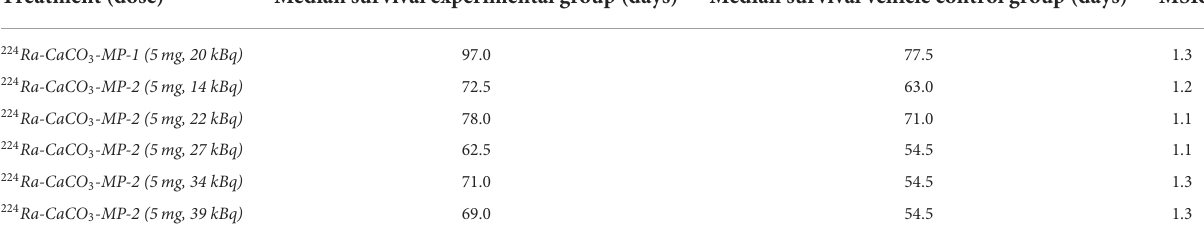
TABLE 1 Median survival ratios (MSRs) for 224 Ra-CaCO 3 -MP as a single treatment compared to vehicle control. Treatment (dose)